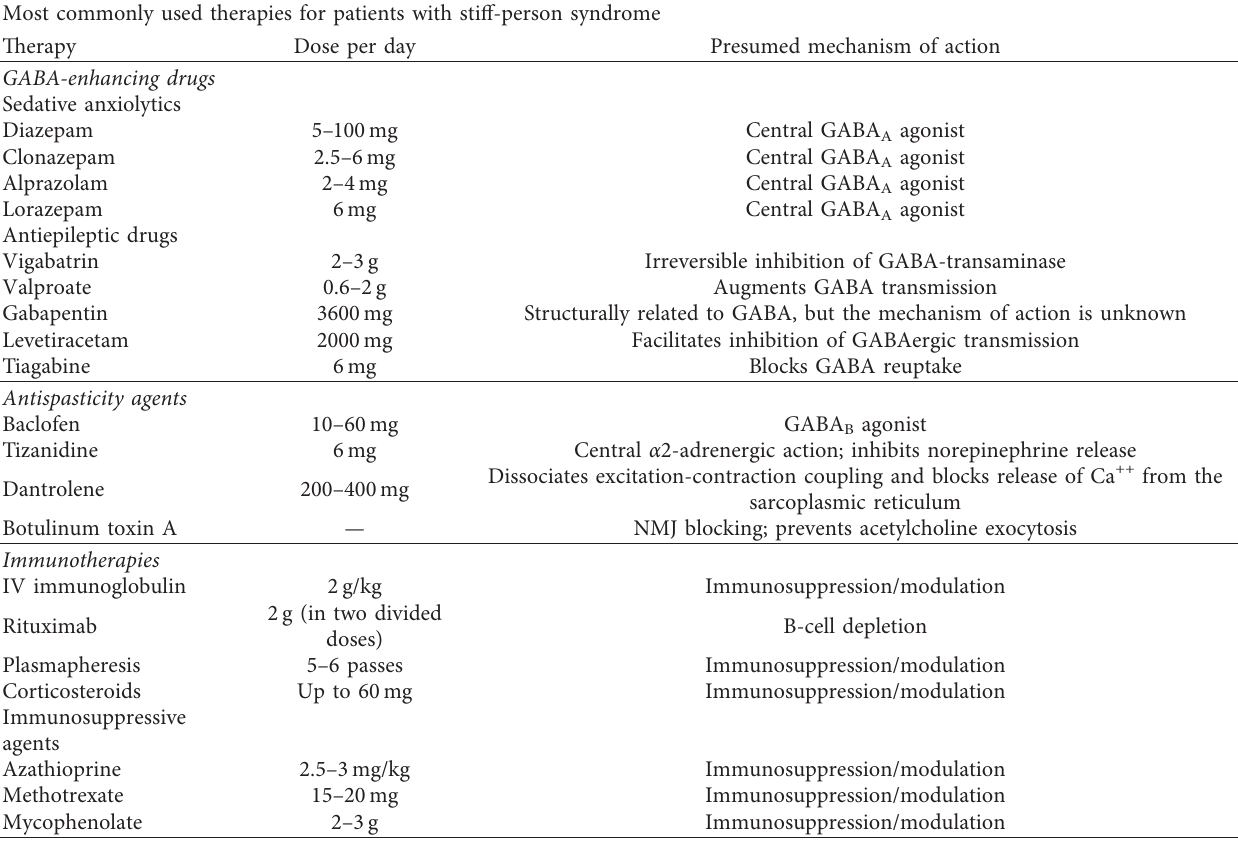
Table 2: Most commonly used therapies for patients with stiff-person syndrome [13]. Most commonly used therapies for patients with stiff-person